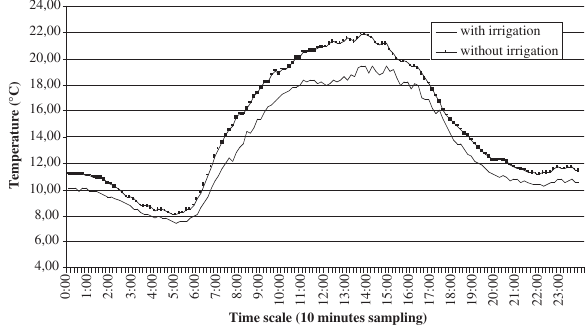
Figure 1. Mean daily temperature in the pear plantation with and without irrigation between March 15 and April 15,